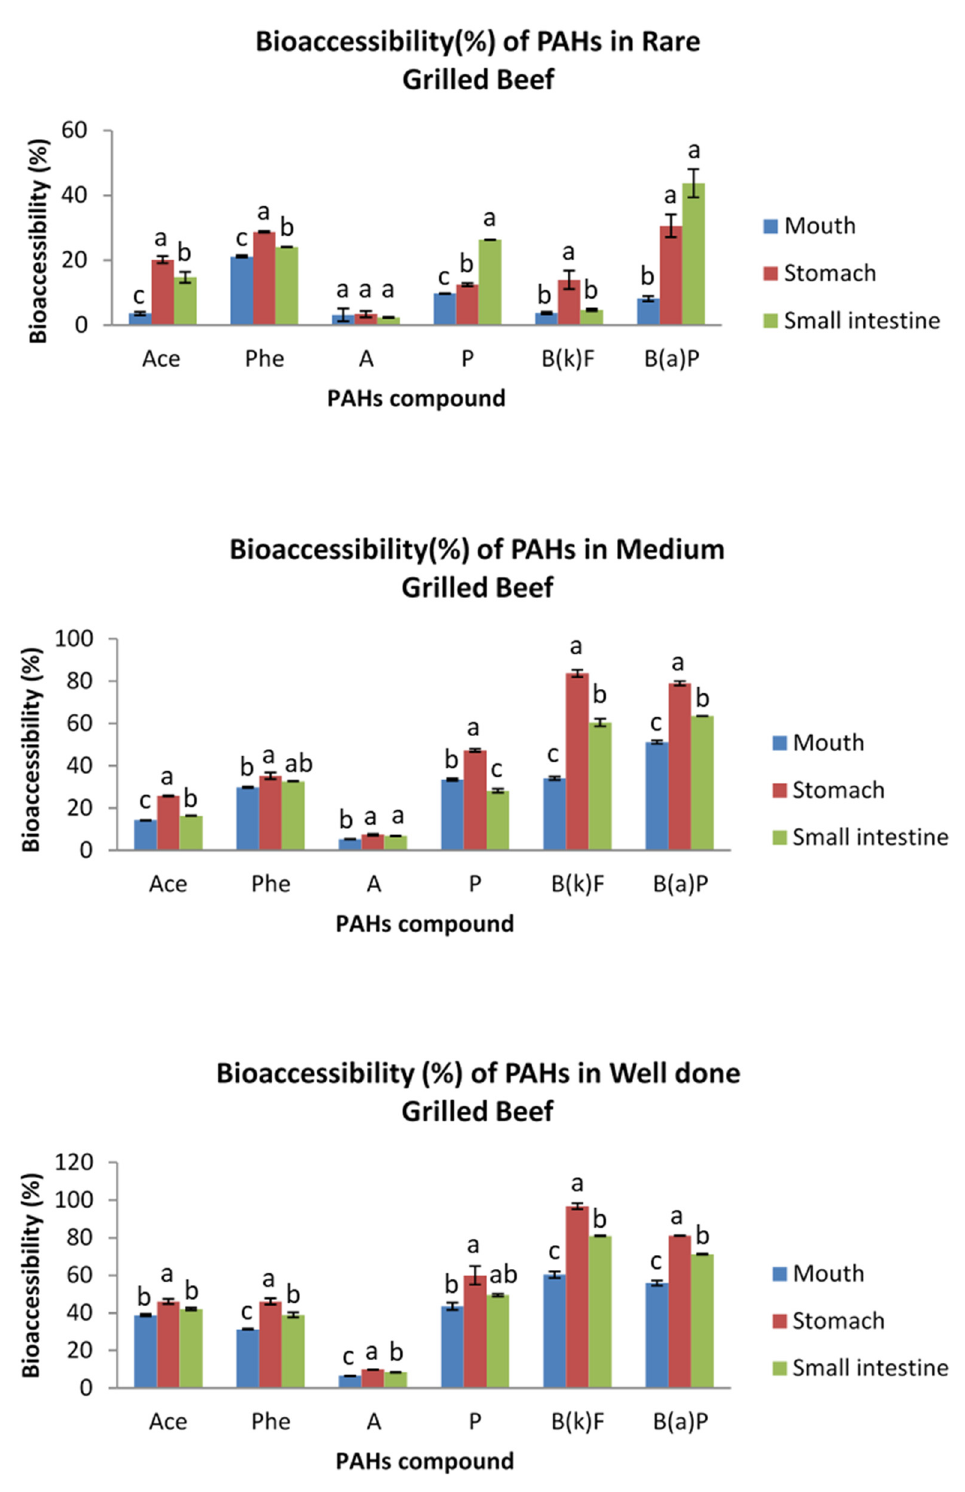
Figure 2. Bioaccessibility (%) of PAHs in rare, medium and well-done grilled beef samples in different parts of digestive system. Different letter indicates significant difference in PAH’s bioavailability among the different parts of the digestive system. Ace, acenaphthene; Phe, phenanthrene; A, anthracene; P, pyrene; B(k)F, benzo(k)fluoranthene; B(a)P, benzo(a)pyrene.